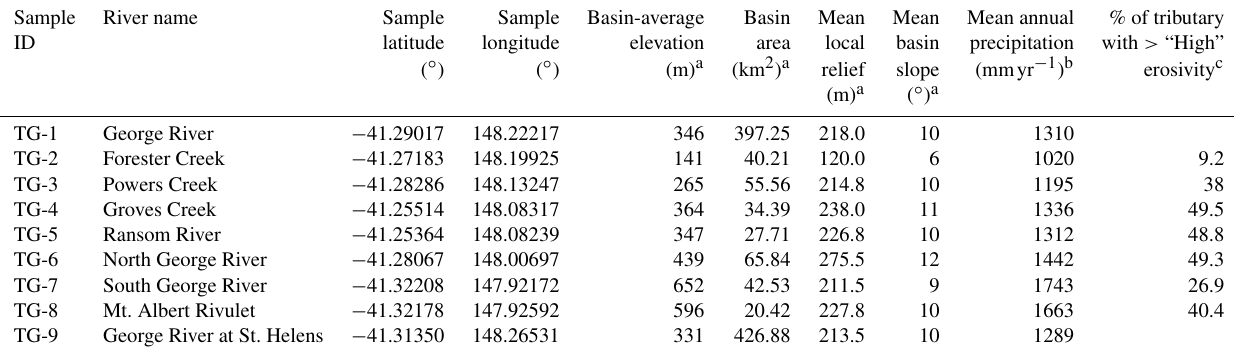
Figure 3. (a) Mean annual precipitation from active (cyan triangles) and inactive (inverted cyan triangles) Australian Bureau of Meteorology rainfall gauging stations across George River basin that have at least 1 full year of recorded data exhibiting a strong correlation with station elevation. (b) Mean annual temperature (green stars) taken from temperature loggers with > 2 years of nearly daily data showing a strong inverse correlation with elevation. Precipitation and temperature data shown in Table 1. Table 2. Sample locations and topographical basin